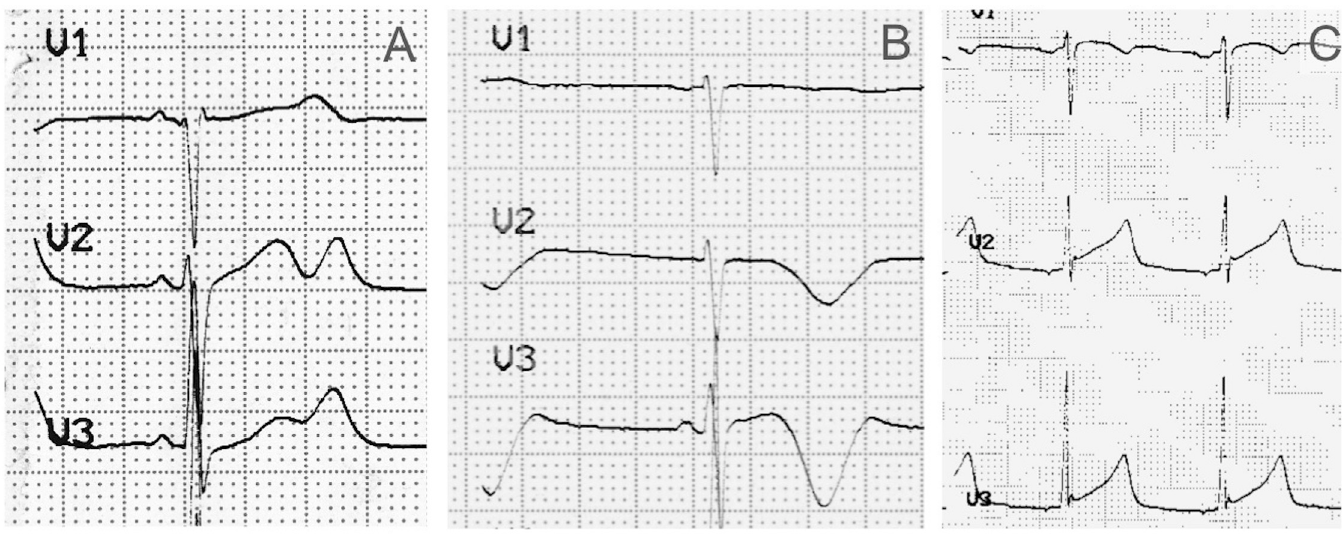
Fig 3. Representative ECG traces of misdiagnosed probands, showing typical LQTS features. Panels A to C show basal ECG from three KCNH2 mutation carriers with extremely prolonged QT intervals and abnormal T-wave shape (A: notched T wave, B: inverted and wide T wave, and C: widened T wave). Panel D shows an ECG recording during one of the syncopal attacks with convulsive status suffered by the patient in panel A, who corresponds to patient II in Table 2, demonstrating a torsade de pointes episode that required external defibrillation.